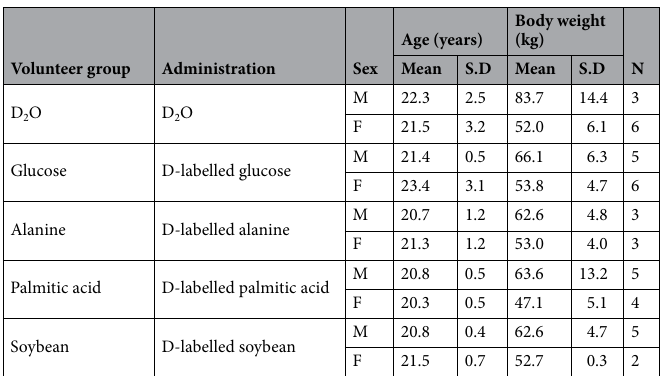
Table 6. Volunteer groups. M, male. F, female. S.D., standard